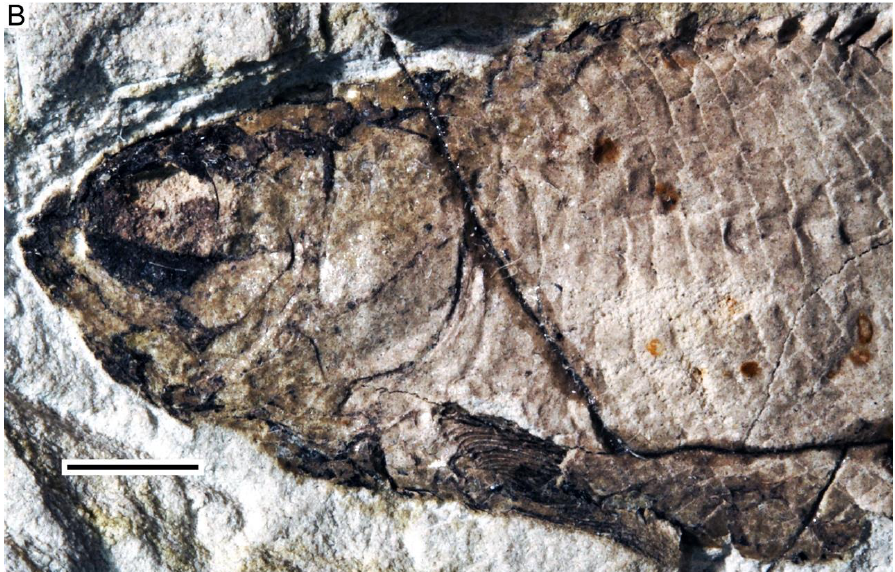
Figure 2. Seinstedtia parva gen. et sp. nov., from horizon MFL, Section F1, Fuchsberg Quarry near Seinstedt, Lower Saxony, upper Norian, Upper Triassic. ( A ) paratype MLU Sei.2010.83 in dorsolateral view; the skull roof, indicated by arrows, is ventro-laterally displaced; ( B ) head and anterior part of body of holotype MLU Sei.2010.76. Scale bars = 3 mm. Photograph, courtesy of John Chorn.